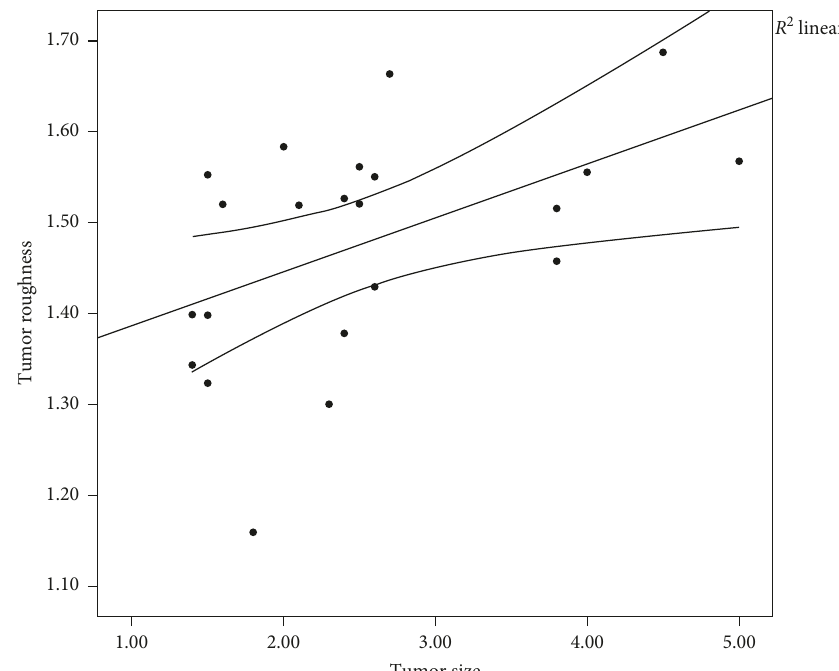
Figure 4: Scatter plot noting the correlation between renal mass size and tumor roughness score (Pearson’s p � 0 .